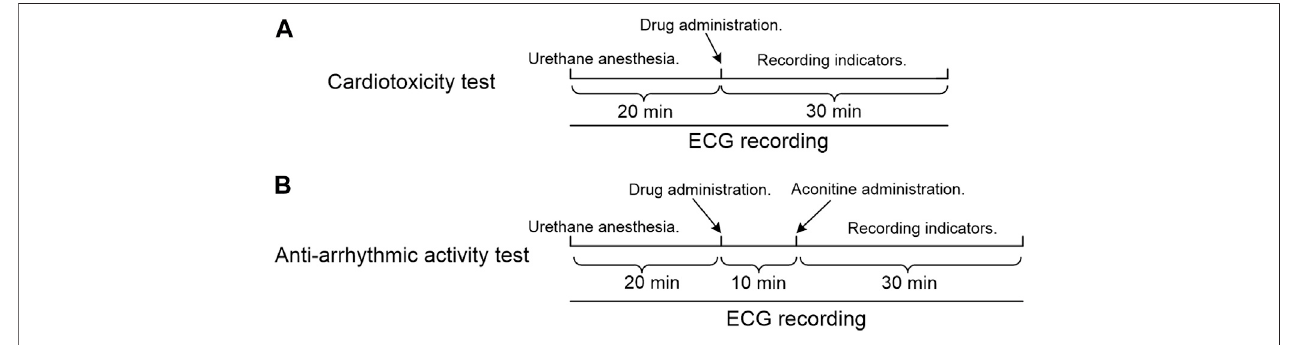
FIGURE 1 | Experimental timeline. (A) Cardiotoxicity test; (B) Anti-arrhythmic activity